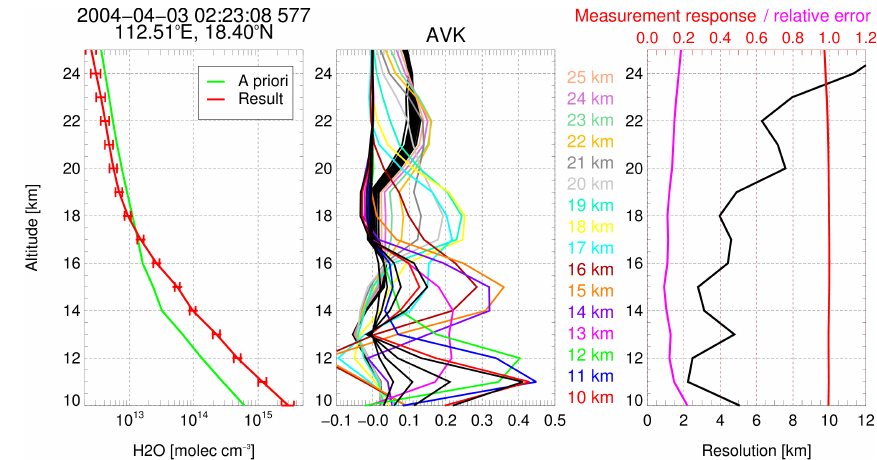
Figure 1. Left panel: an example of a water vapour profile resulting from the retrieval. Middle panel: corresponding averaging kernels. The colour marks the rows of the AVK matrix for heights between 10 and 25km; rows for heights above and below are displayed in black. Right panel: vertical resolution (black), measurement response (red), and relative error of the retrieved profile (pink, top axis